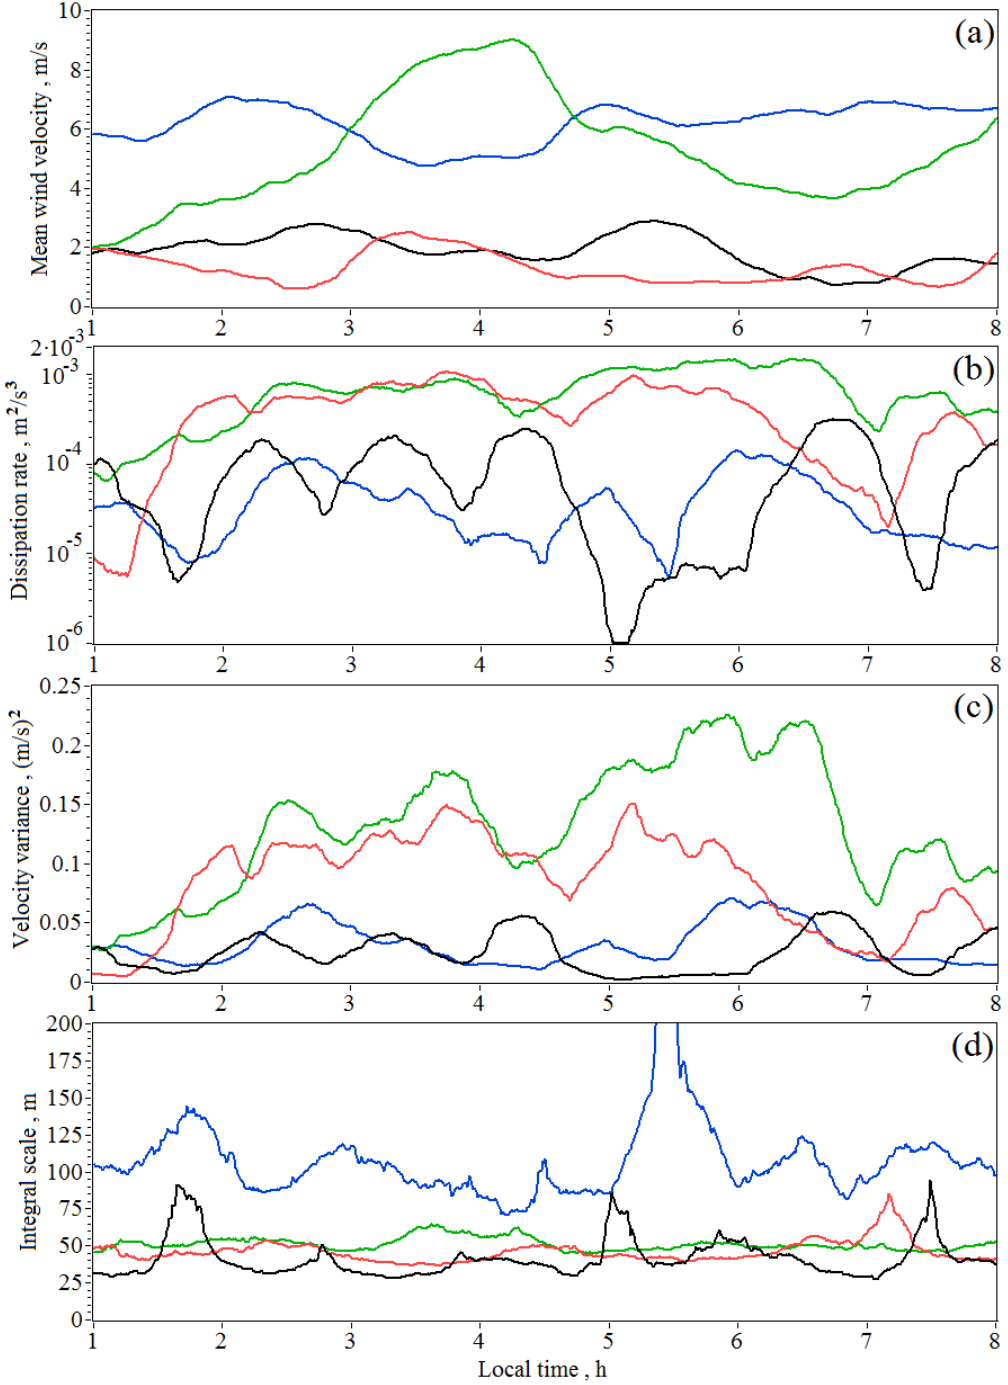
Figure 9. Temporal variations of the wind velocity ( a ), turbulence energy dissipation rate ( b ), variance of turbulent fluctuations of the radial velocity ( c ), and integral scale of turbulence ( d ) at heights of 150 m (black curves), 300 m (red curves), 450 m (green curves), and 600 m (blue curves), as obtained from measurements by the StreamLine lidar at the Baikal coast on 24 August